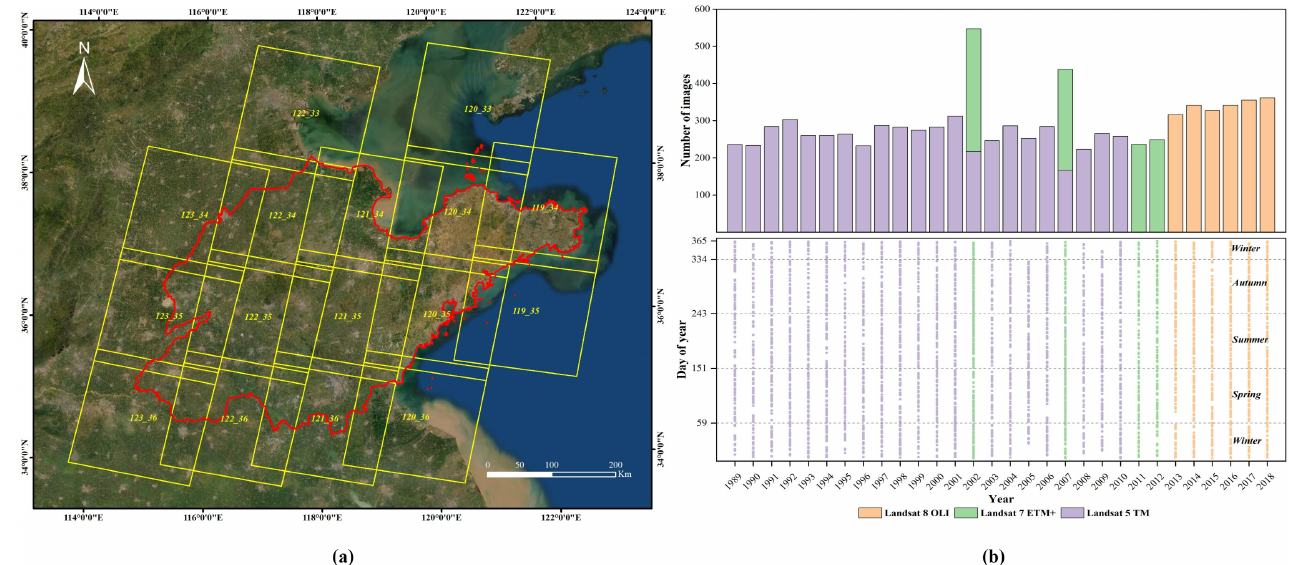
Figure 2. Spatiotemporal distribution (DOY, day of year) of Landsat images used in this study: ( a ) Landsat tiles in Path 119–123 and Row 33–36, ( b ) the acquisition time of Landsat